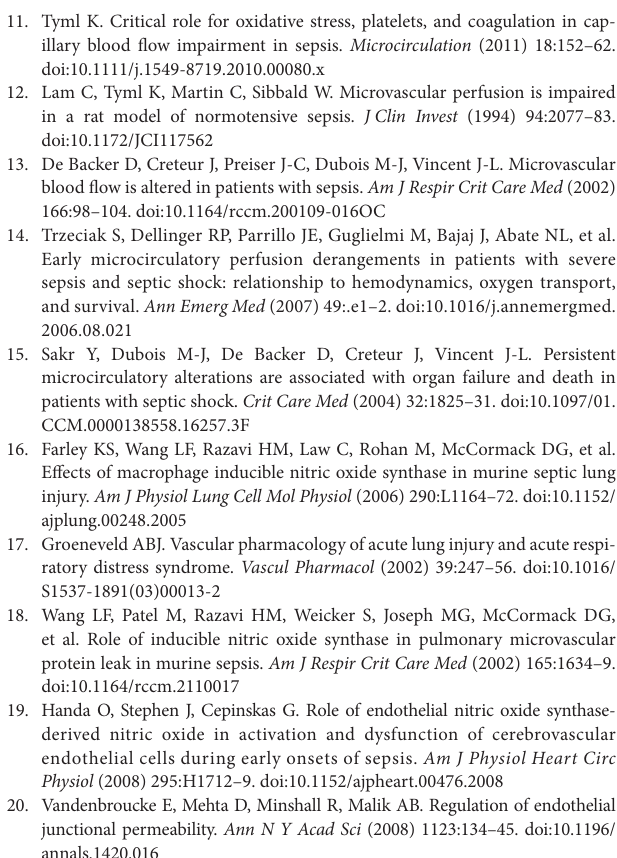
FigUre s1 | Schematic of neutrophil (PMN)–pulmonary microvascular endothelial cell (PMVEC) coculture and septic stimulation. PMN and PMVEC were individually stimulated with cytomix (equimolar human tumor necrosis factor α , interleukin 1 β , and interferon γ in PBS) at 0.3 and 3 ng/mL vs. PBS control. After 3 h, PMN were added to the corresponding PMVEC monolayer (PMN:PMVEC ratio = 10:1), and cocultured together with or without cytomix stimulation for another 2 h. EC barrier function was assessed by measuring transendothelial electrical resistance (TEER) at 0, 3, and 5 h. To examine trans-PMVEC macromolecular flux, Evans blue (EB)-labeled bovine serum albumin (BSA; 67 kDa) and fluoroisothiocyanate (FITC)-labeled dextran (4 kDa) were added to the apical aspect of the PMVEC (upper chamber of the transwell) at 5 h post-cytomix. The transwell insert was removed at 6 h post-cytomix and the amount of EB-BSA and FITC-dextran in the lower chamber assessed. Note: for the sake of simplicity, the term EC refers specifically to PMVEC within all figures. FigUre s2 | Cytomix treatment of human PMVEC induces caspase-dependent intercellular gap formation. (a) Cytomix-treated isolated PMVEC had obvious intercellular gaps (arrows) at 5 h vs. PBS, and the gap area in each image was quantified as a percentage of the total PMVEC monolayer area, in both isolated PMVEC [ (B) EC alone] and for PMN–PMVEC coculture [ (c) EC + PMN]. The cytomix-induced increase in PMVEC intercellular gaps was completely prevented by pan-caspase inhibition in PMVEC pre-treated with Q-VD (B,c) . N = 3–4/ group. ** p < 0.01 for cytomix vs. respective PBS; ## p < 0.01 for Q-VD vs. cytomix